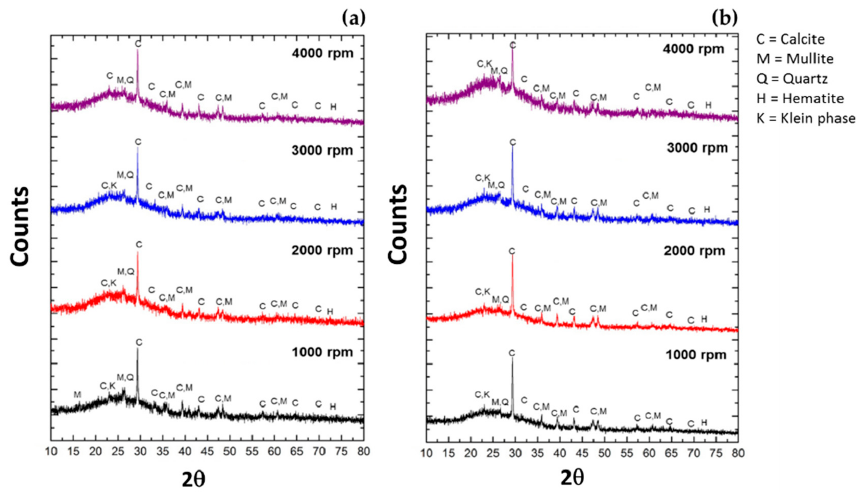
Figure 6. X-ray diffraction patterns of cenospheres collected by centrifugal method using the centrifugal speeds of 1000, 2000, 3000, and 4000 rpm, and the centrifugal times of ( a ) 10 min and ( b ) 30 min.